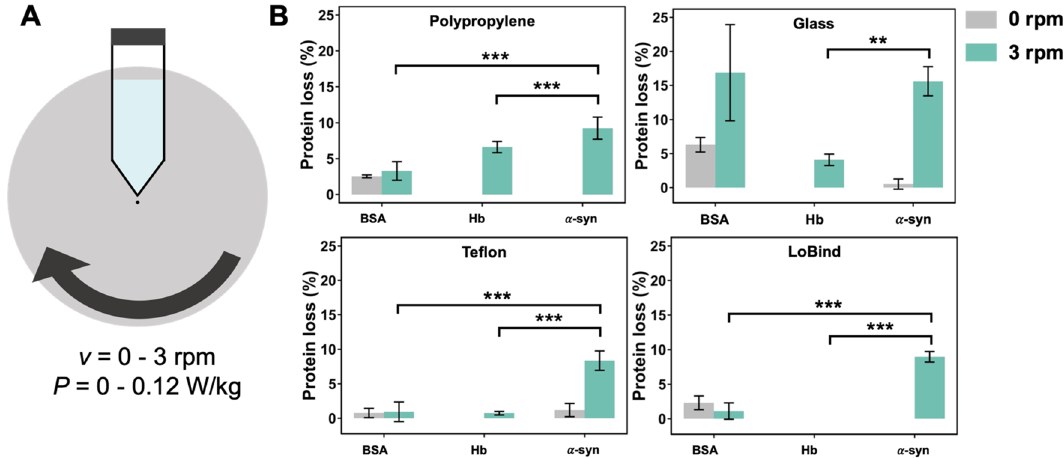
Figure 1. ( A ) Scheme of the experimental setup designed to measure protein loss during agitation of purified protein solutions with a rotating wheel. The speed ranged from 0 to 3 rpm, corresponding to a power from 0 to 0.12 W/kg. Tubes made of PP, glass, TEFLON, LOBIND were used. A conical PP FISHERBRAND tube is represented. ( B ) Protein loss of BSA, Hb, α-syn solutions measured in PP, glass, TEFLON and LOBIND tubes after 24 h at 6 °C without (grey) and with agitation at 3 rpm (green) on a rotating wheel. The initial protein concentration was C 0 = 0.1 g/L (V = 10 mL). Significant differences are determined using the Tukey’s “honestly significant difference” test realized from variance analysis (Anova) (*** p -value < 0.001; ** p -value < 0.01). To observe the effect of the protein nature, only the differences at 3 rpm are shown, all the statistical results are available in Table S3.